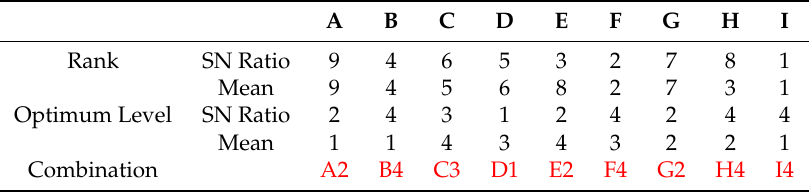
Figure 8. Signal to noise ratio plot for each of the GA parameters. Table 3. Optimal combination parameters from the response